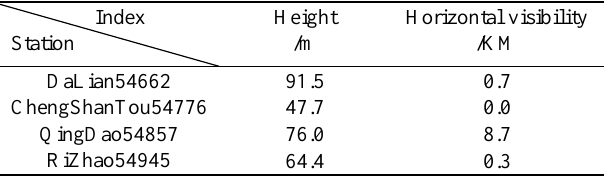
Table 3. Visibility Information of Coastal Meteorological Station Data at 10:00